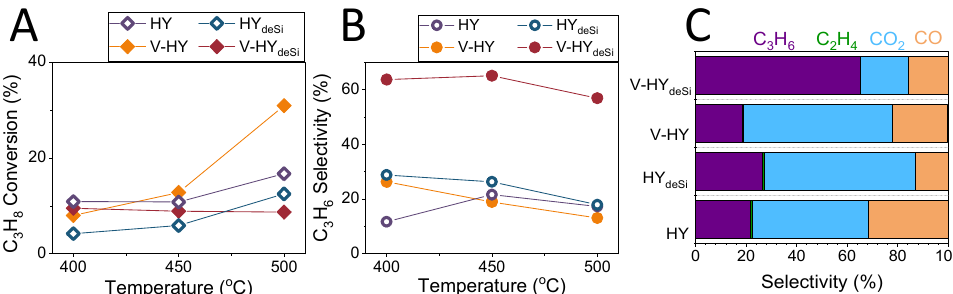
Figure 7. Conversion of propane ( A ), selectivity to propene ( B ) and propane ODH products distribution determined for the H ‐ and V ‐ catalysts at various temperatures (contact time 0.33 s) ( C ) [35].